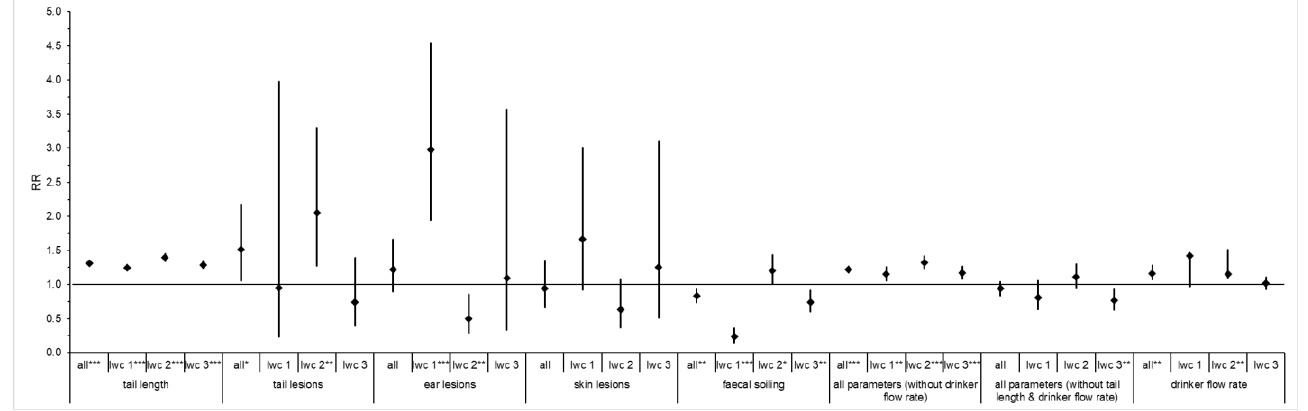
Figure 1. Relative risks (RR, diamond) and the corresponding confidence intervals (vertical lines) for each parameter for all farms and for the respective live weight classes (lwc) (RR = 1 no difference between ITW and CONV farms (horizontal line), if RR > 1 then RR for ITW pigs is lower, if RR < 1 then RR for ITW pigs is higher); number of * denotes significant differences: * = p - value ≤ 0.05, ** = p - value ≤ 0.01, *** = p - value ≤ 0.001 .